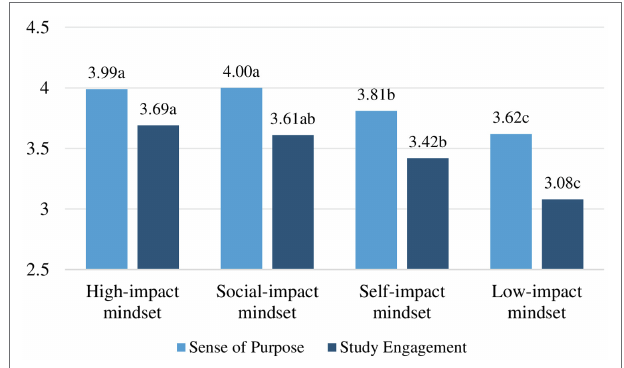
FIGURE 1 | Student mean levels in sense of purpose and study engagement. (Different letters denote significant differences between motivational